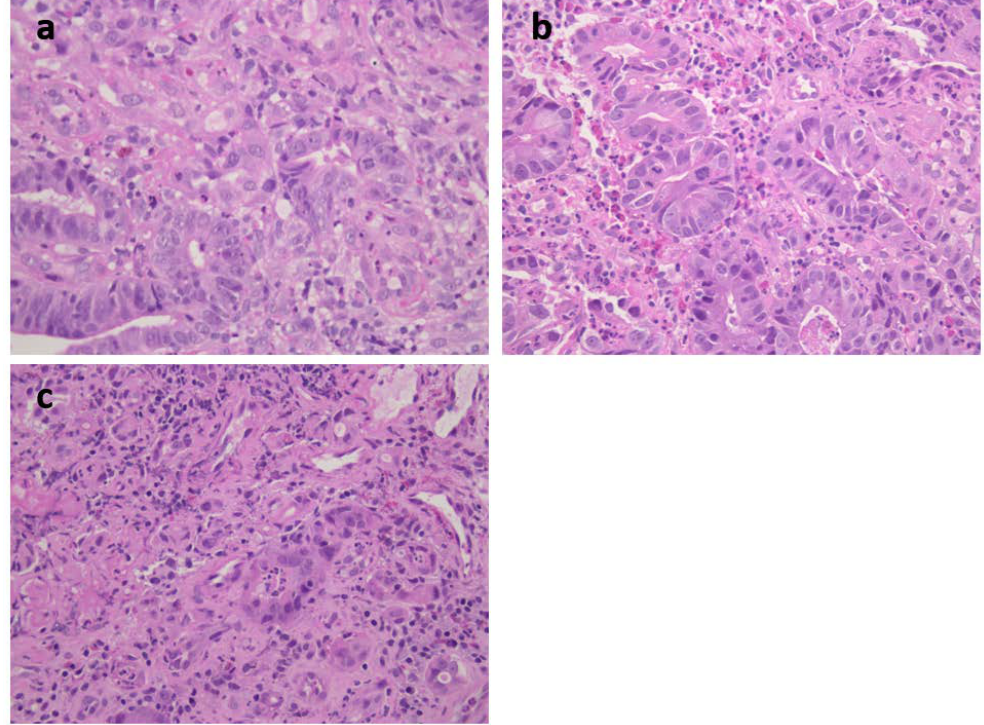
Figure 4. ( a ) Patient 2: moderately differentiated intestinal-type adenocarcinoma; ( b ) Patient 3: moderately differentiated intestinal-type adenocarcinoma; ( c ) Patient 4: moderately and poorly differentiated intestinal-type adenocarcinoma; H&H staining, original magnification 400 × .